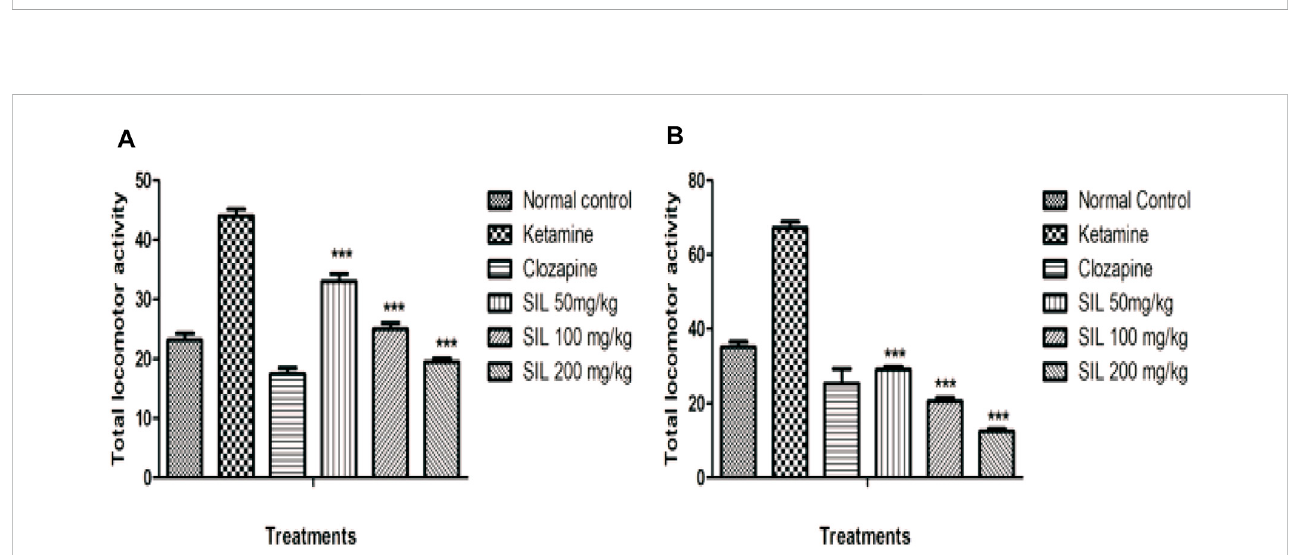
EffectofSILonketamine-inducedstereotypyinpreventive (A) andcurative (B) protocols.Valuesexpressedhereasmean±SEM;n=10,where** p < 0.01, *** p < 0.001 compared to the ketamine group.